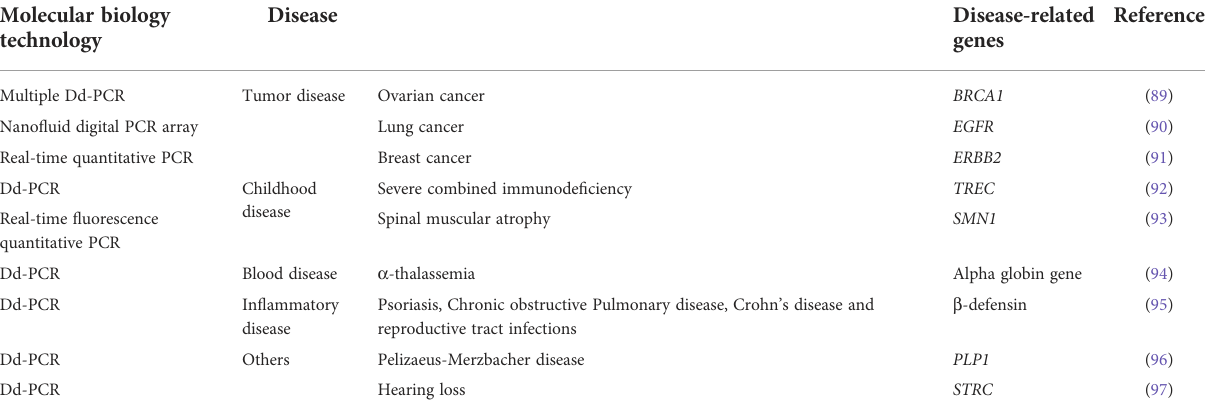
TABLE 1 Application of RPP30 as an internal